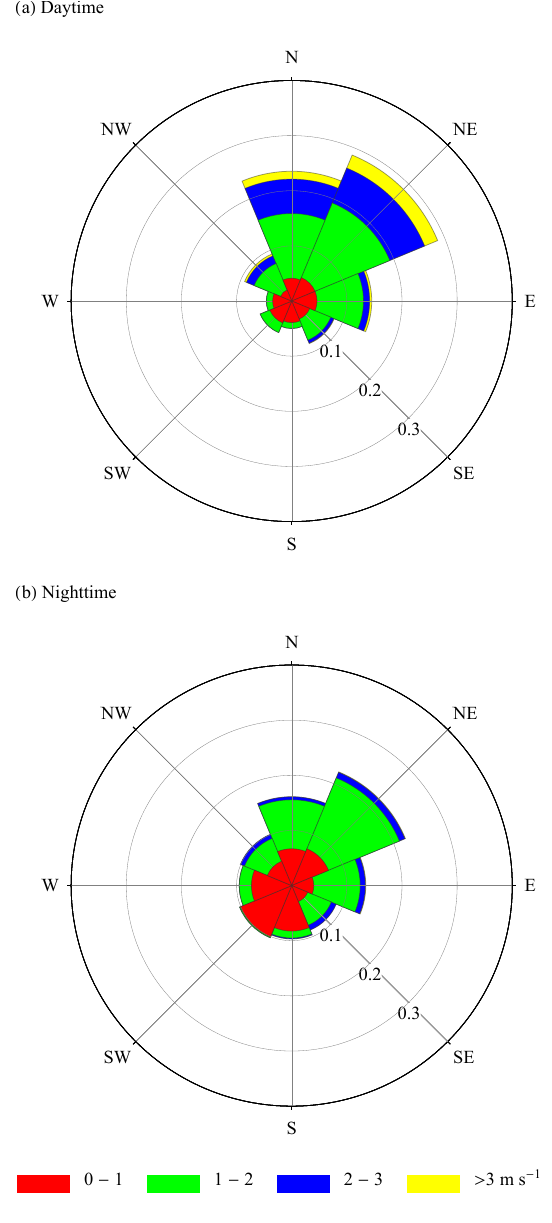
Fig. 5. Daytime and nighttime wind roses measured at the top of tower TT34 during AMAZE-08. The concentric circles represent the fractional frequency of winds from different sector directions. Within each sector, the color coding of radial distance indicates the relative frequencies of the wind speeds.